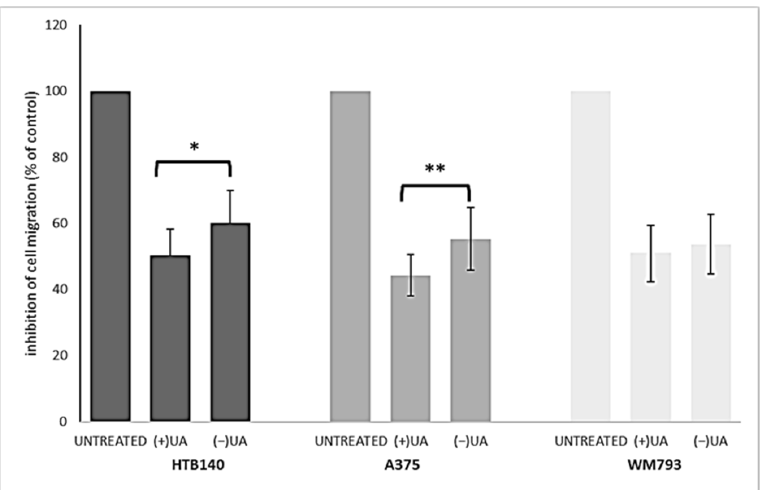
Figure 3. The effect of (+)- and ( − )-usnic acid on migration ability of HTB140, A375 and WM793 human melanoma cells. Cells were treated or not (untreated) with 10 µ g/mL of (+)-usnic acid (+UA) or ( − )-usnic acid ( − UA) for 24 h. Values are presented as the mean ± SD (standard deviation) of 10 randomly selected fields of view. Experiments were run twice in a blindfolded manner. Statistical analyses were carried out by using one ‐ way ANOVA and Tukey post ‐ hoc test. Significant differ ‐ ences (* p < 0.05 and ** p < 0.01) between usnic acid enantiomers were marked by upper black line.